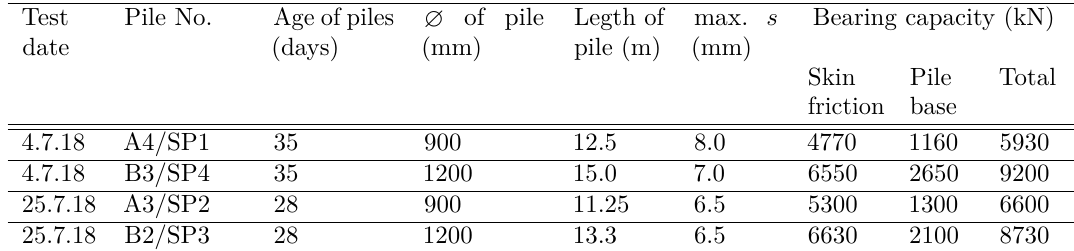
Table 2. Evaluation of test piles by PDA.